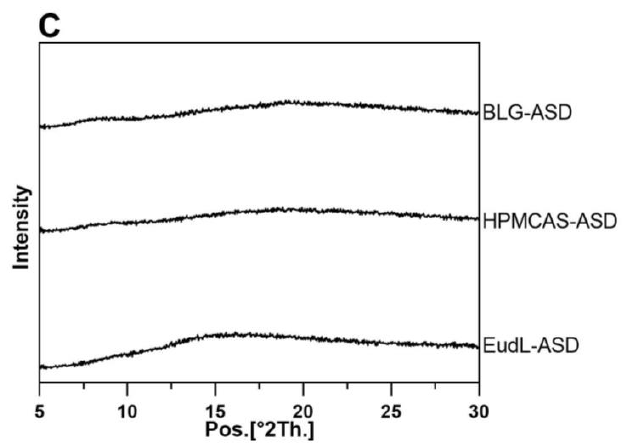
Figure 1. XRPD diffractograms of ( A ) bulk RFX, physical mixture (PM) , ( B ) the freshly prepared ASD samples, and ( C ) the ASD samples stored for 5 weeks under accelerated conditions at 40 °C/75%RH. Table 1. T g s and moisture contents of different materials.